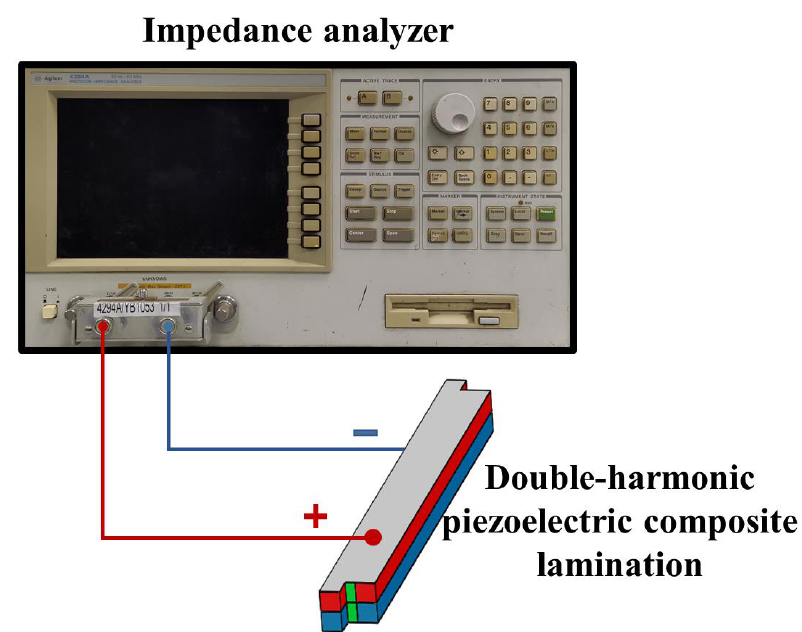
Figure 10. Diagram of the test method for laminated samples.